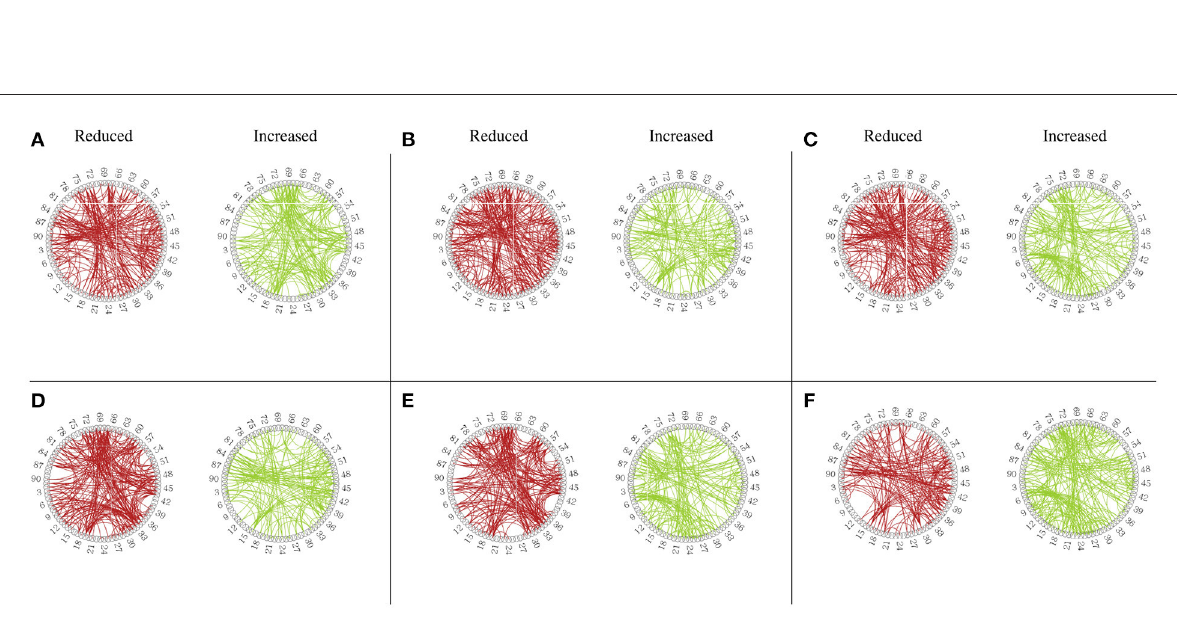
FIGURE9 Circular graph of altered functional connectivity in MCI patients among 90 Anatomical Automatic Labeling (AAL) atlas regions. (A) From NC to SMC. (B) From NC to EMCI. (C) From NC to LMCI. (D) From SMC to EMCI. (E) From SMC to LMCI. (F) From EMCI to